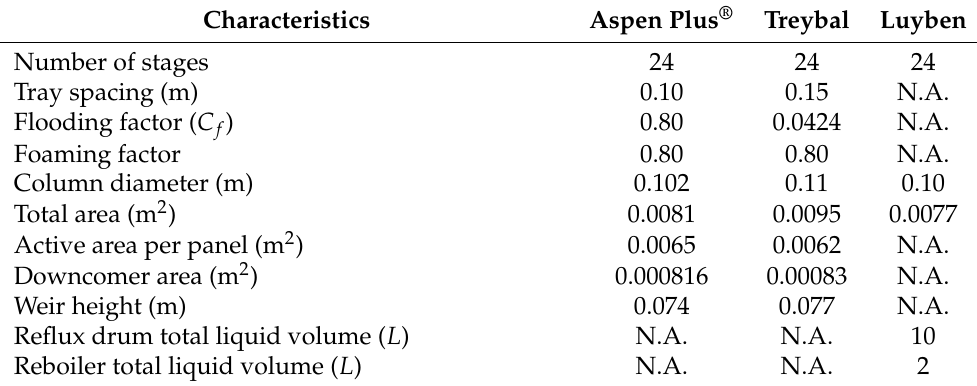
Table 4. Characteristics of the column of the saline extractive distillation column. Characteristics Aspen Plus ® Treybal Luyben 24 24